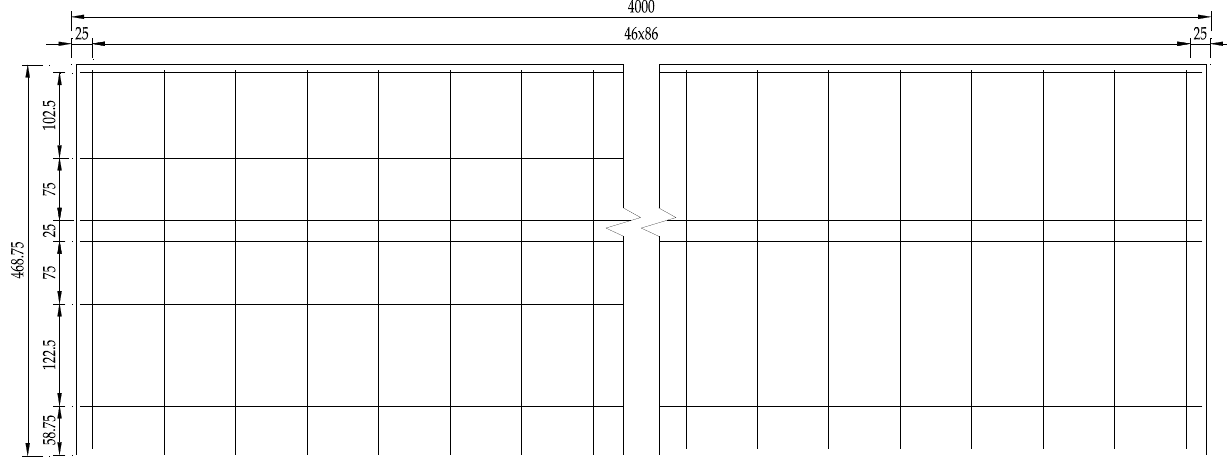
Figure 3. The longitudinal diagram of the bridge slab model (unit: mm).